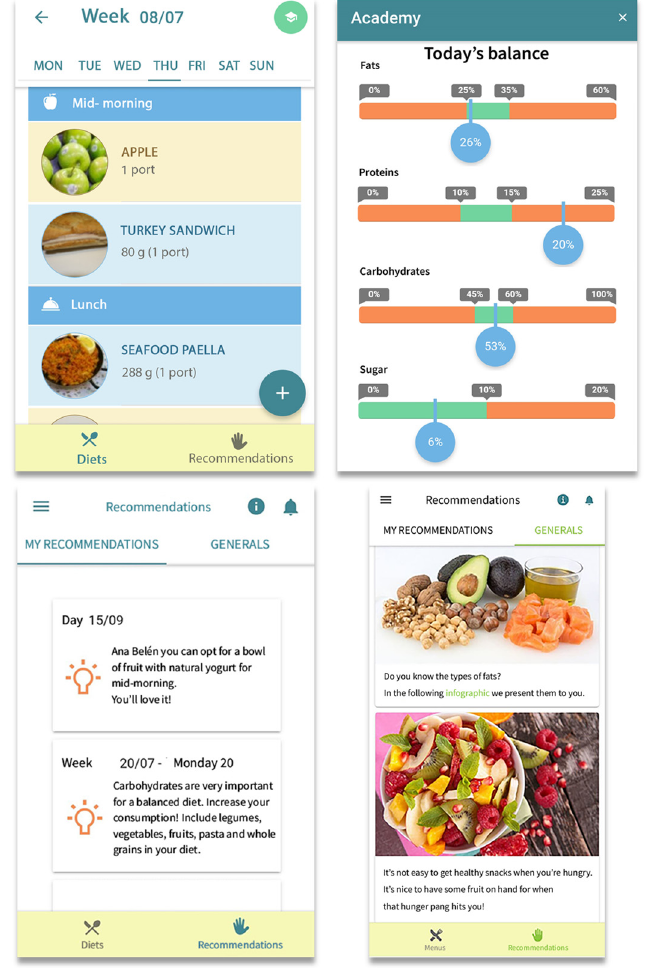
Figure 2. Screenshots of the SAlBi educa